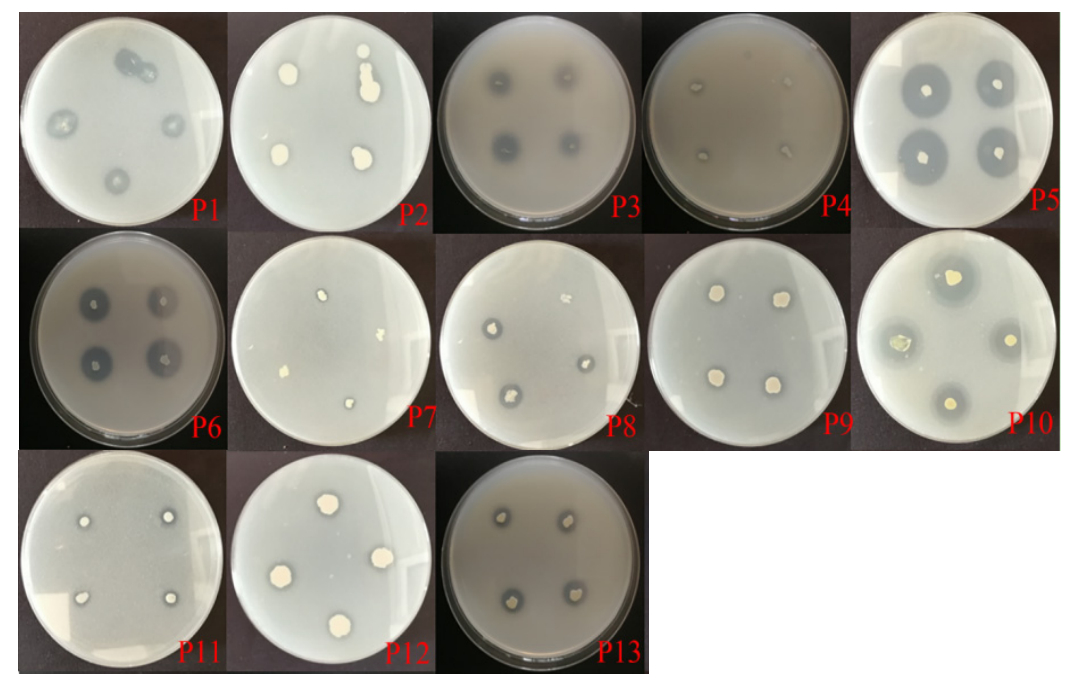
Figure 1. Strain growth traits.